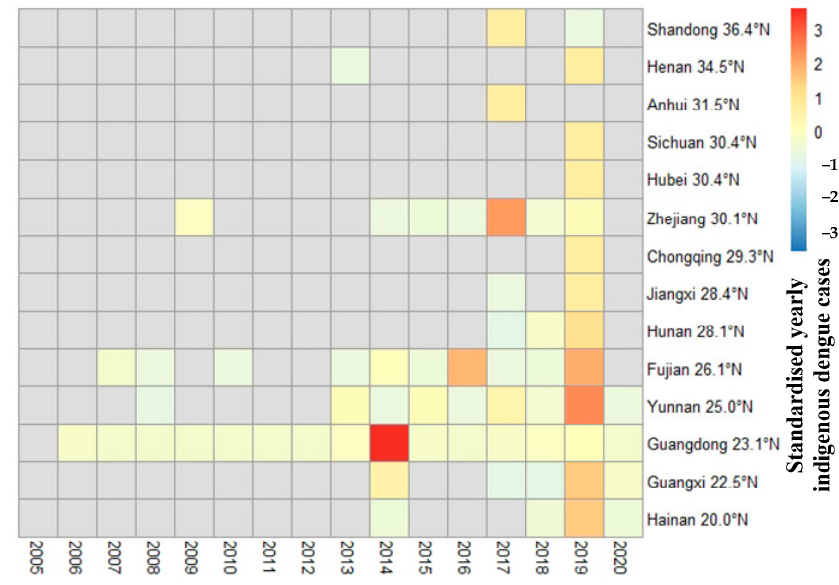
Figure 4. Heat map of indigenous dengue cases in mainland China in 2005–2020.